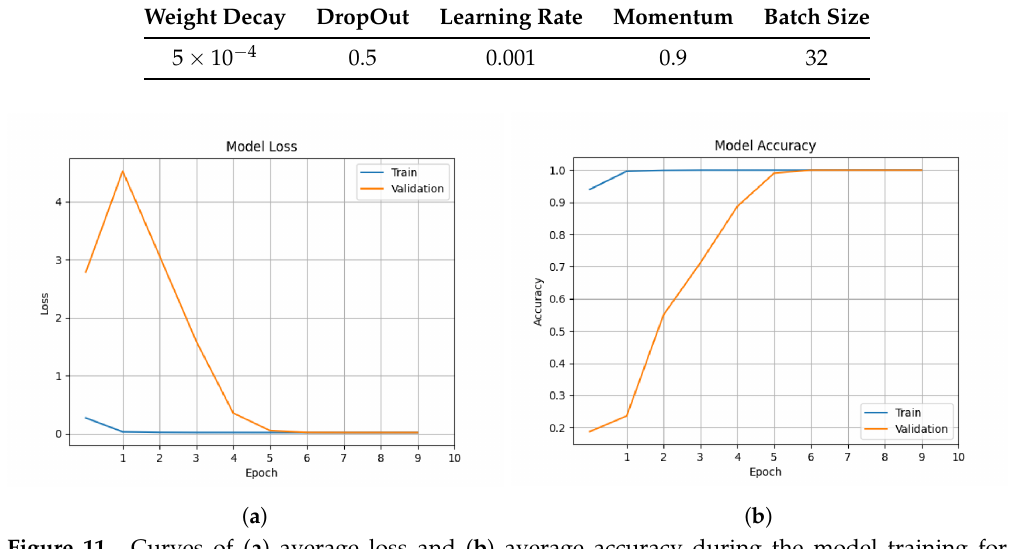
Table 4. Parameters of the CNN model for fruit classification.